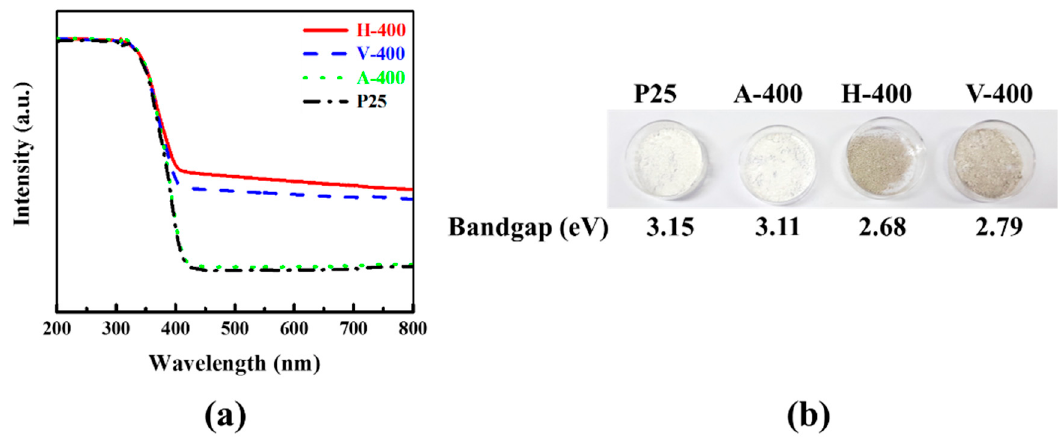
Figure 2. ( a ) UV-vis spectra, ( b ) colour turning image and energy band gap of samples.